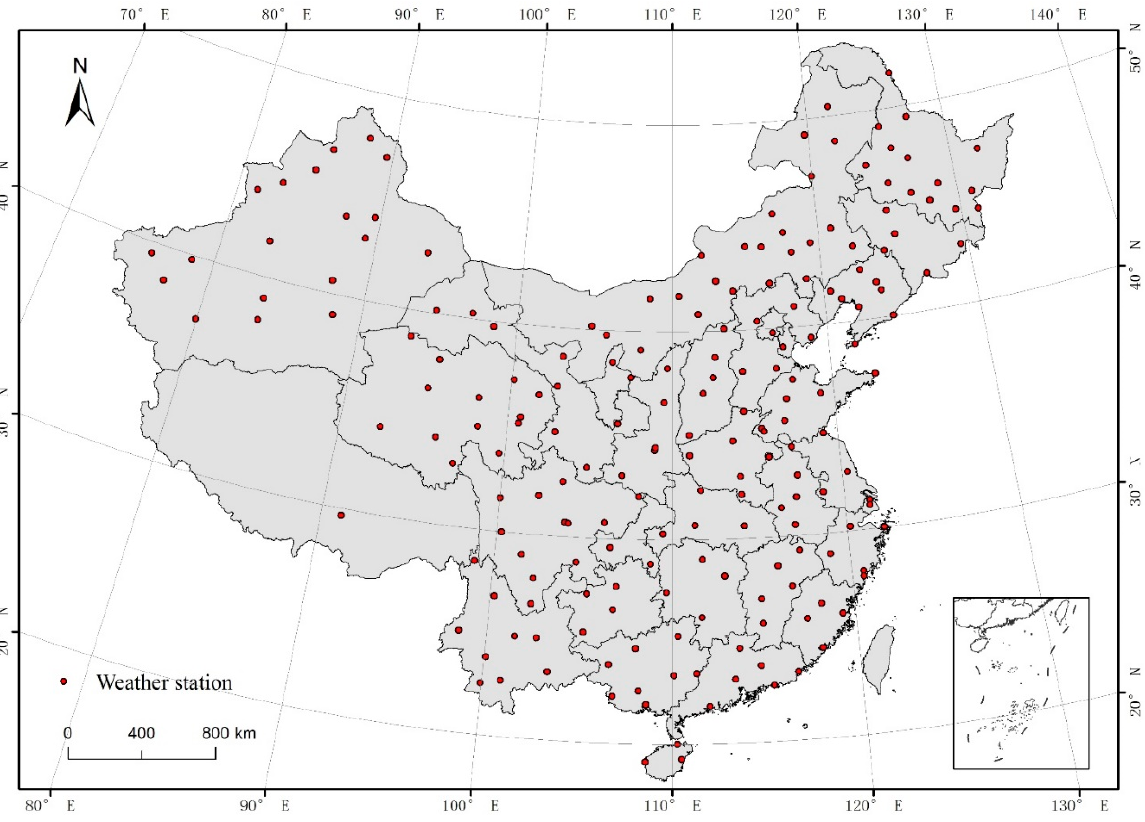
Figure 1. Map showing the spatial distribution of weather stations across China.